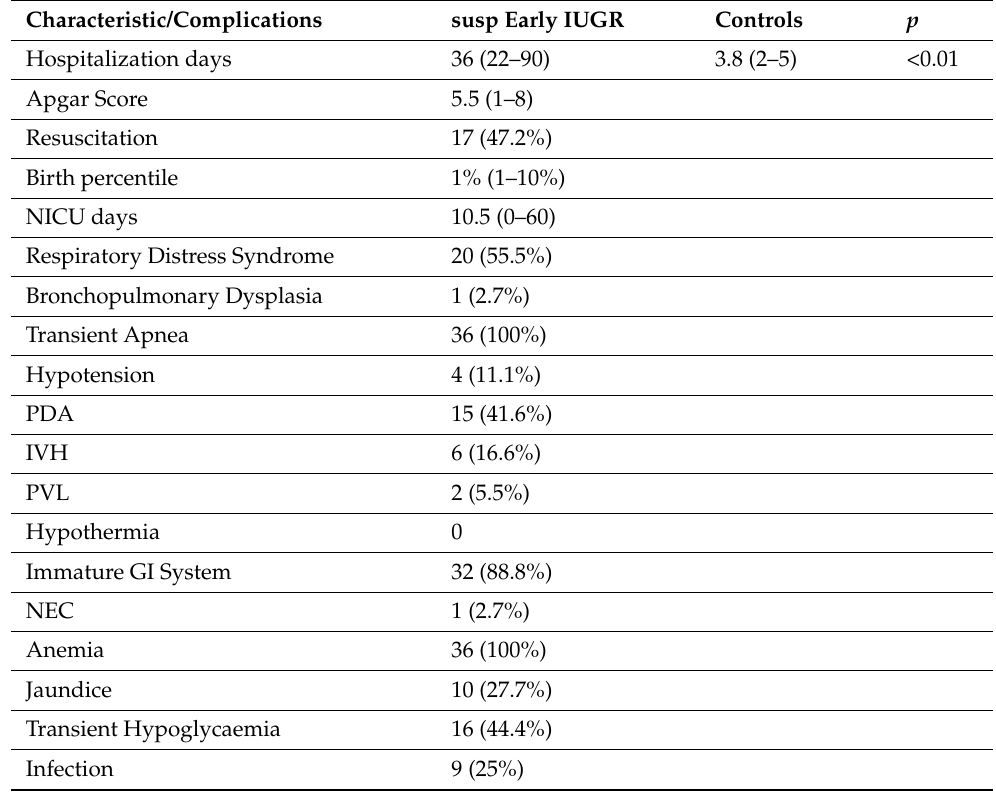
Table 3. Newborn data in pregnancies complicated with early